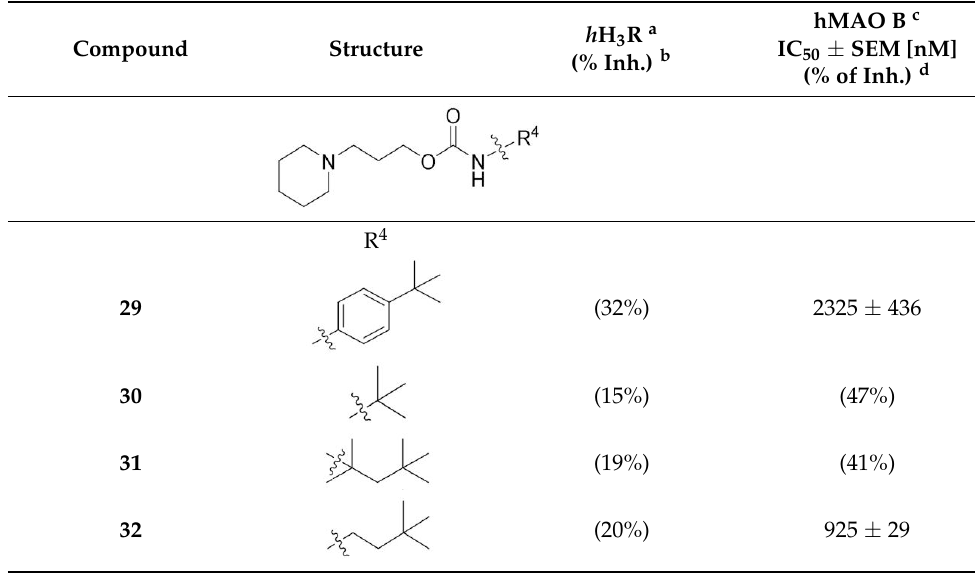
Table 4. In vitro affinities for human histamine H 3 receptor and human MAO B inhibitory activities of the target compounds 29 – 32